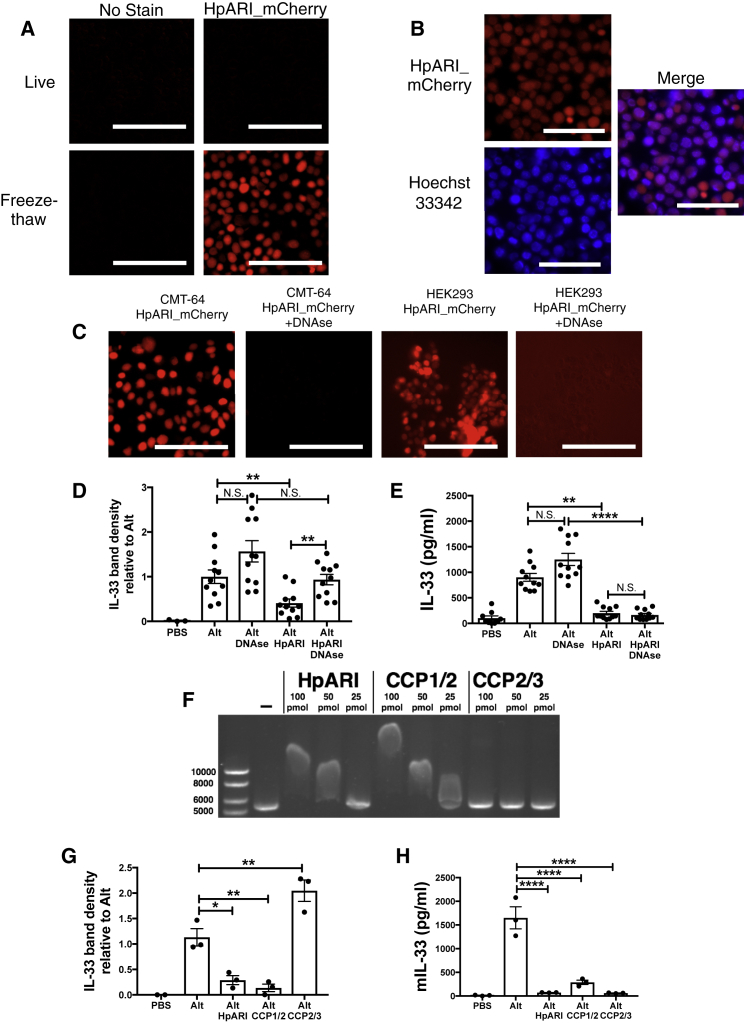
HpARI Binds Nuclear DNA, Tethering IL-33 within Necrotic Cells(A) Live (top panels) or freeze-thawed (bottom panels) CMT-64 cells were incubated for 1 hr at 37°C with 5 μg/ml HpARI_mCherry.(B) HpARI_mCherry-stained freeze-thawed CMT-64 cells, with Hoechst 33342 nuclear co-stain.(C) Freeze-thawed CMT-64 or HEK293T cells were stained with HpARI_mCherry with 100 U/ml DNAse I.(D) Murine IL-33 western blot densitometry of BAL taken 15 min after Alternaria allergen, HpARI and DNAse (100 U) intranasal administration.(E) Murine IL-33 levels (ELISA) IL-33 in BAL fluid from mice described in (D)(F) Gel shift assay of linearised plasmid DNA, incubated with 100, 50 or 25 pmol of HpARI, CCP1/2 or CCP2/3 truncated proteins.(G) Murine IL-33 western blot densitometry of BAL taken 15 min after Alternaria allergen, HpARI or CCP1/2 or CCP2/3 HpARI truncated proteins intranasal administration.(H) Murine IL-33 levels (ELISA) in BAL from mice described in (G).All data representative of at least 2 repeat experiments. Data in (D) and (E) shows mean and SEM of 3 pooled experiments, data log-transformed for statistical analysis to equalize variances. Scale bars = 100 μm. Error bars show SEM.